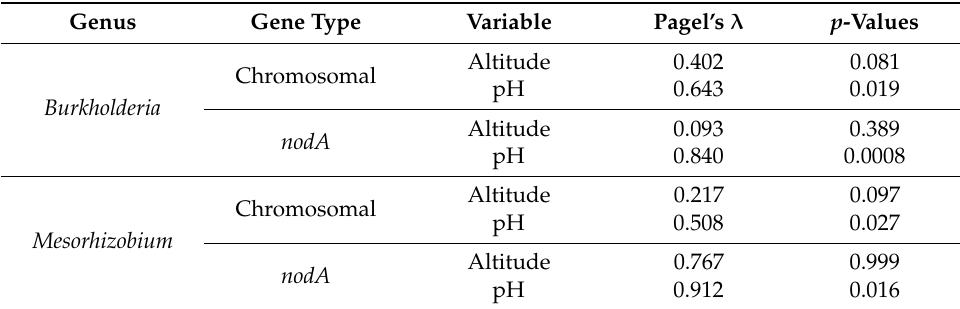
Table 2. Results of the tests of phylogenetic signals for altitude and pH using Pagel’s λ on the chromosomal (16S rRNA and recA ) and nodA trees of Burkholderia and Mesorhizobium. Genus Gene Type Variable Pagel’s λ p -Values Altitude Chromosomal pH Burkholderia Altitude nodA pH Altitude Chromosomal Mesorhizobium